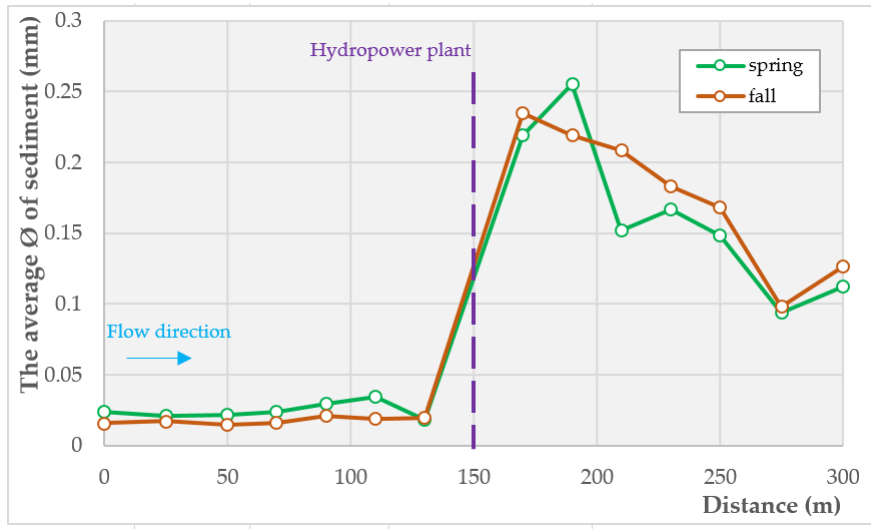
Figure 3. Average grain diameter of the tested sediments near the hydroelectric power plant on the Ślęza River.